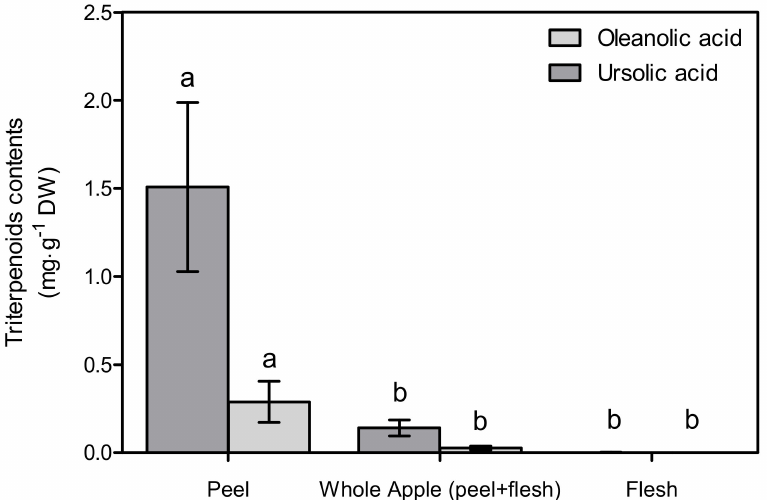
Figure 2. Triterpenoid contents of pre-washed apple peel, whole apple, and flesh. Different letters indicate significant differences ( p < 0.05) among the tissues by Tukey’s HSD test ( n = 3). Whole apple bioactive contents were calculated per peel and flesh